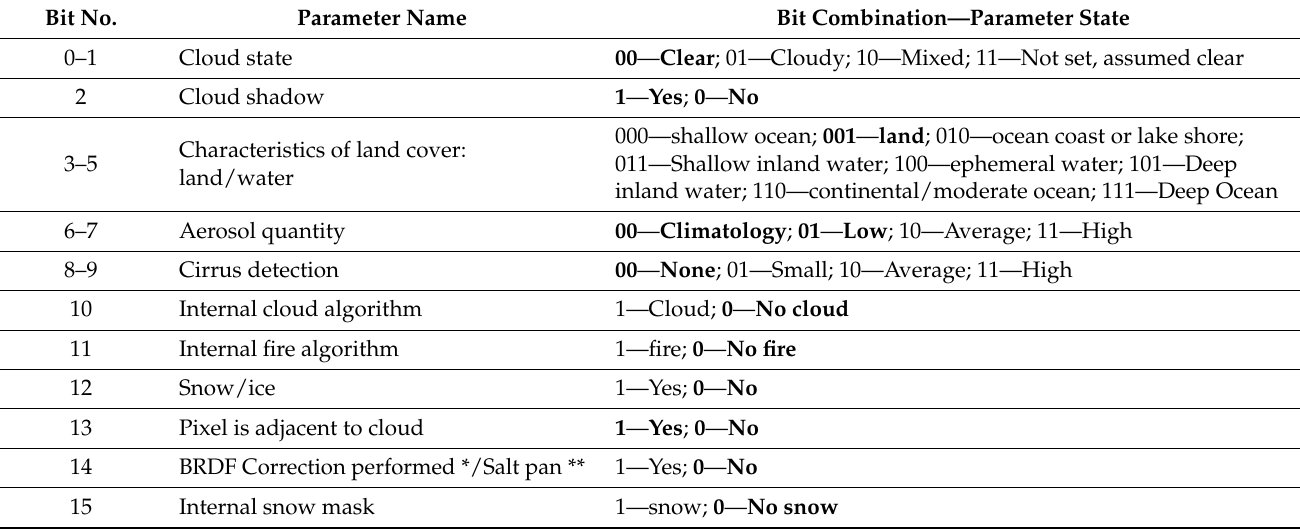
Table 1. MOD09GA/MYD09GA—1 km Reflectance Data State Quality Assurance layer. Accepted combinations are indicated by values and text in bold.